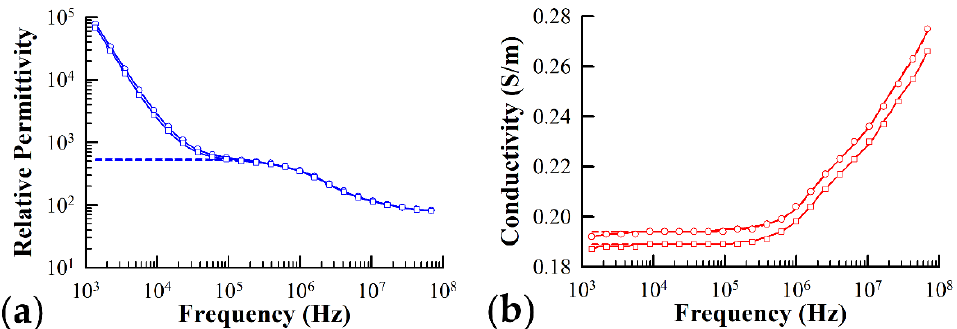
Figure 3. Typical plots of the relative ( a ) permittivity and ( b ) conductivity of yeast cells expressing the sterile2 α -factor receptor protein in the presence (circles) and absence (squares) of the α -factor ligand. The theoretical best fit to the measured data predicted by the three-shell model presented in the text is represented by the solid lines. The dashed lines represent the theoretical fit with the correction due to the electrode polarization subtracted off. Fitting parameters used in simulation of measured spectra for cells in the presence of α -factor: d cm = 2.50 nm, d om = 2.50 nm, R = 1.65 µ m, R 0 = 1.25 µ m, v = 0.17, ε a = 78.0, κ a = 0.25 S/m, ε w = 90.7, κ w = 0.04 S/m, ε cm = 2.53, κ cm = 0 S/m, ε cp = 46.5, κ cp = 0.27 S/m, ε om = 12.4, κ om = 0 S/m, ε io = 25.0, κ io = 1.43 S/m, a = 1.13 × 10 5 , b = 0.79. Fitting parameters used in simulation of measured spectra for cells not exposed to α -factor: d cm = 2.50 nm, d om = 2.50 nm, R = 1.65 µ m, R 0 = 1.25 µ m, v = 0.16, ε a = 78.0, κ a = 0.24 S/m, ε w = 90.7, κ w = 0.04 S/m, ε cm = 2.46, κ cm = 0 S/m, ε cp = 62.9, κ cp = 0.33 S/m, ε om = 11.9, κ om = 0 S/m, ε io =25.0, κ io = 1.00 S/m, a = 1.83 × 10 5 , b =